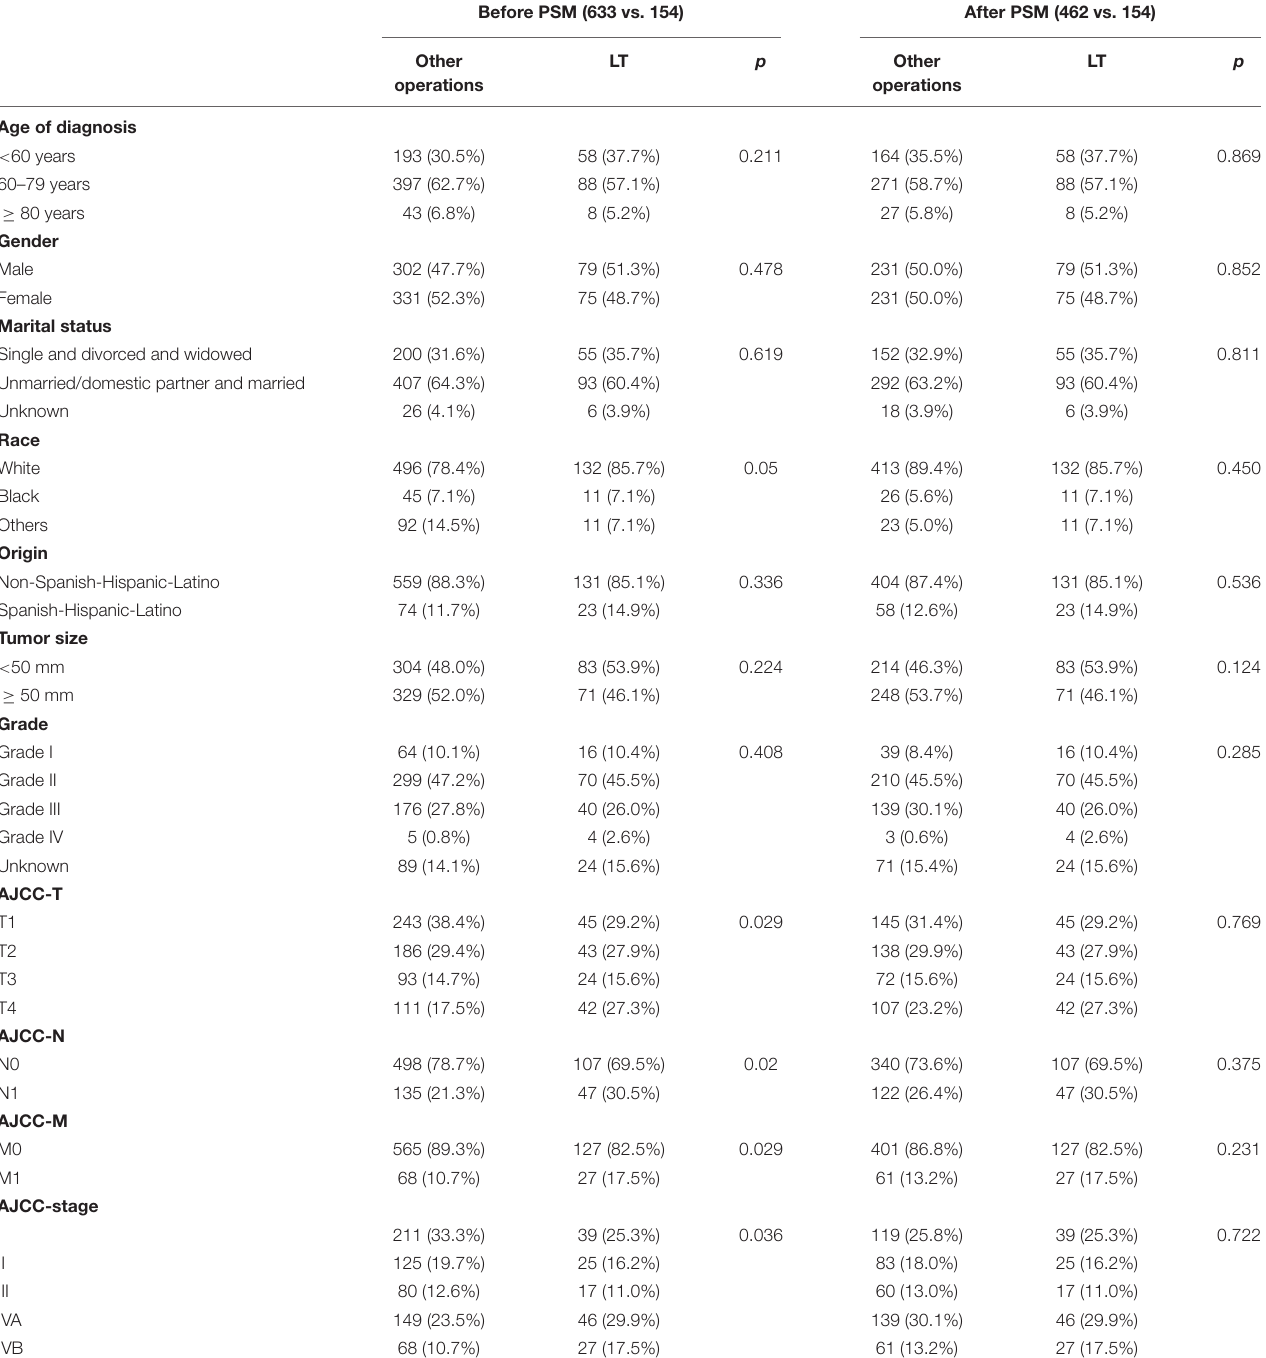
TABLE 3 | Comparison of demographic, clinical and treatment-related Characteristics of the surgery database before and after PSM. Before PSM (633 vs. 154) After PSM (462 vs.